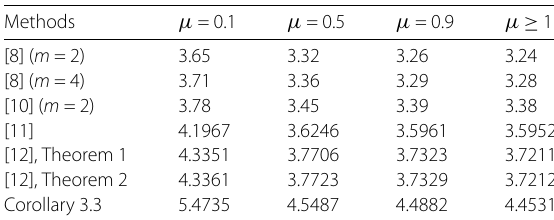
Table 3 The MADBs of τ 2 with τ 1 = 3 for different μ in Example 4.3